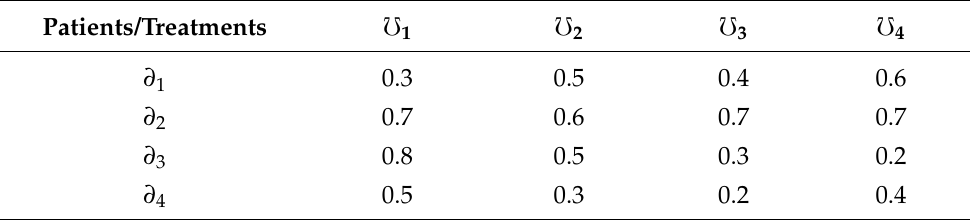
Table 15. W 2 tabular representation: after the second therapy event, the patient’s improvement report. C Patients/Treatments